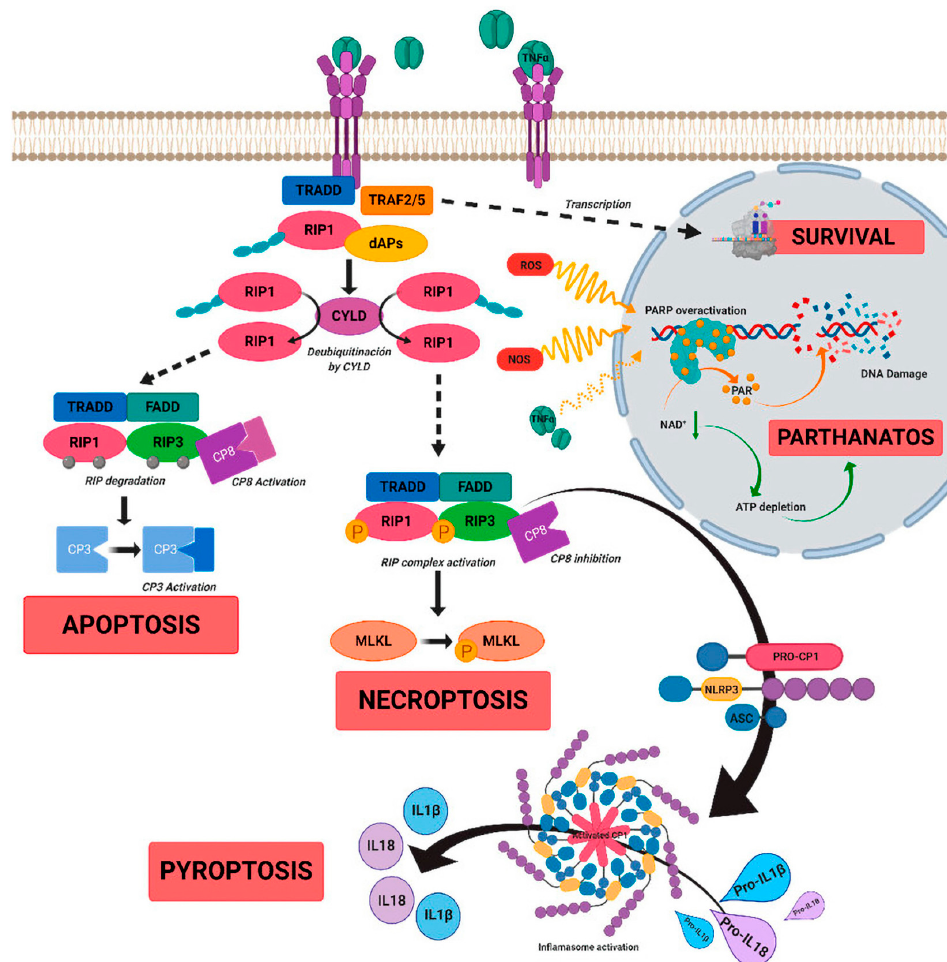
Figure 2. A schematic diagram to show the role of tumor necrosis factor alpha (TNF α ) - signaling in inherited retinal dystrophies. TNF α binds to its receptor TNFR1, which leads to the recruitment of death-domain containing adaptor protein (TRADD). TRADD further recruits TNF receptor-associ- ated factor 2 (TRAF2) and receptor-interacting protein kinase 1 (RIPK1) to form complex 1,